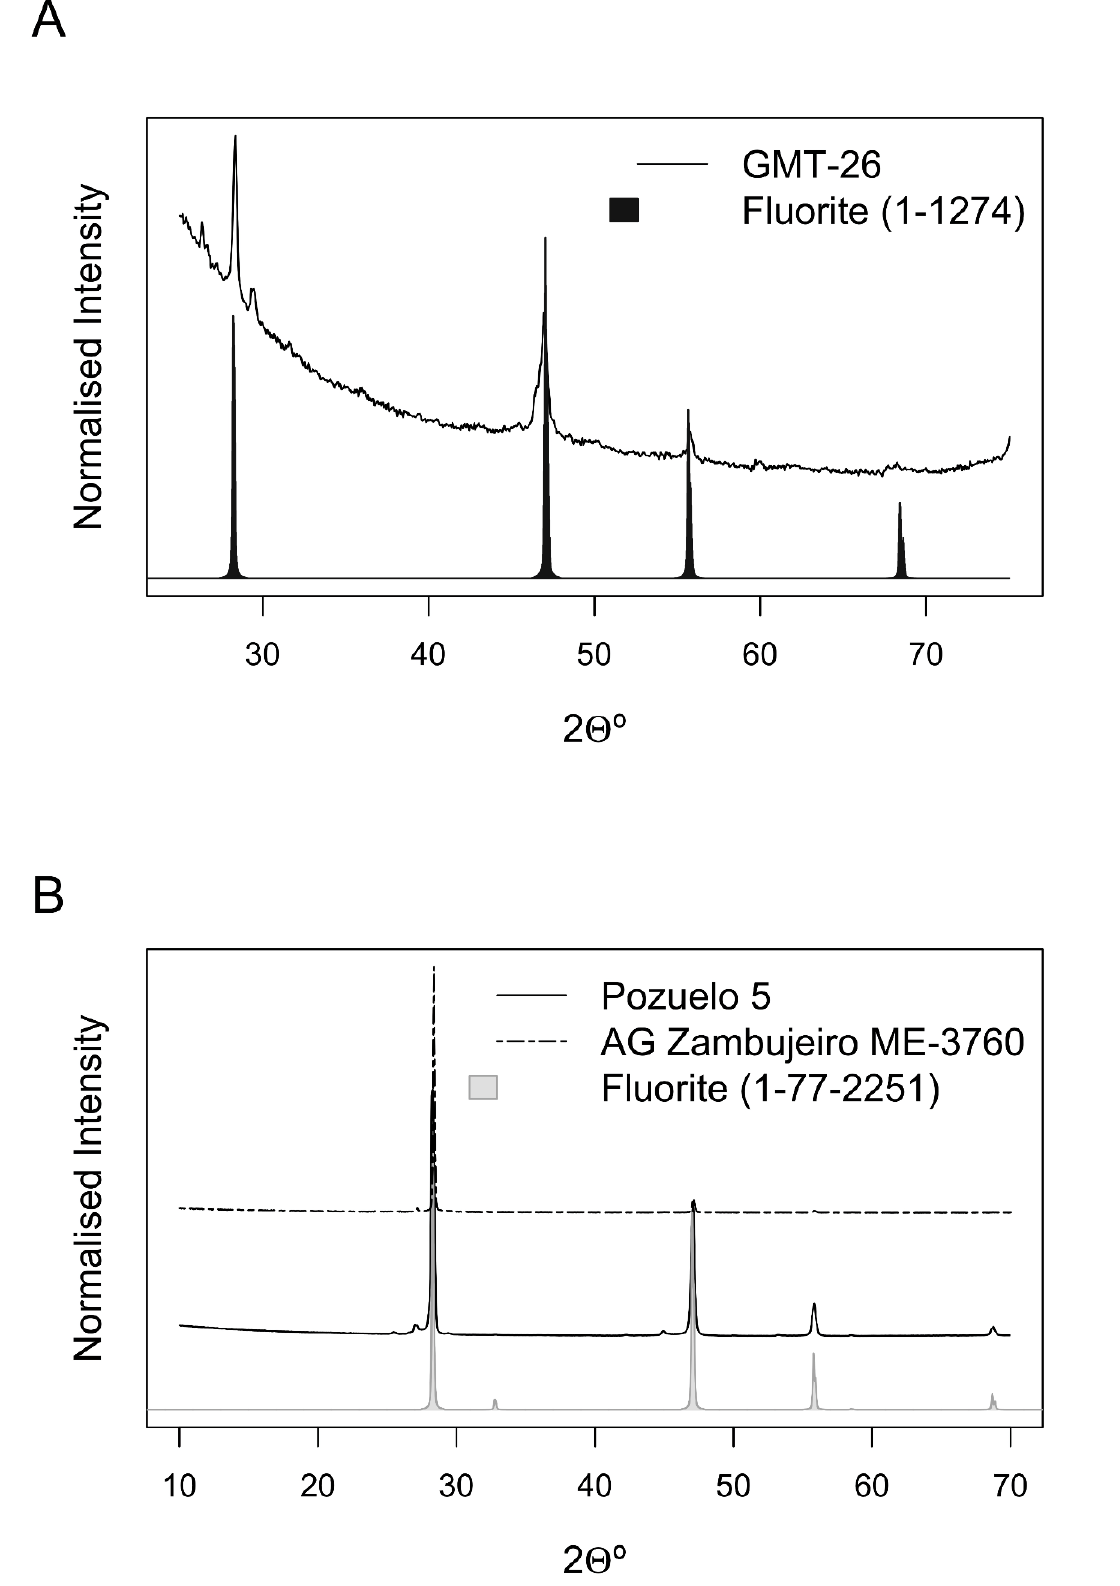
Figure 6. XRD pattern of samples MMT-26 from Gruta da Marmota (A) and El Pozuelo 5 and Anta Grande do Zambujeiro (B) compared to fluorite reference card